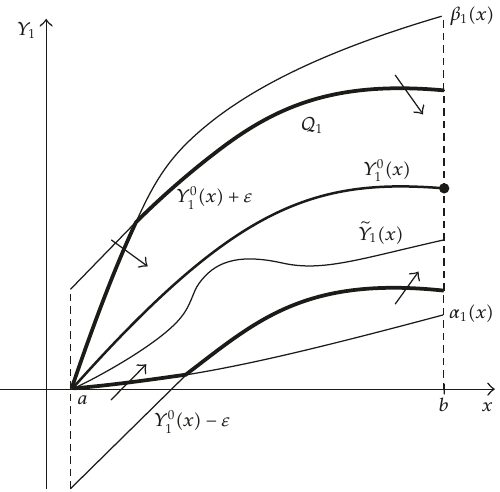
Figure 4: Continuity of T (cid:3) the second case (cid:4)